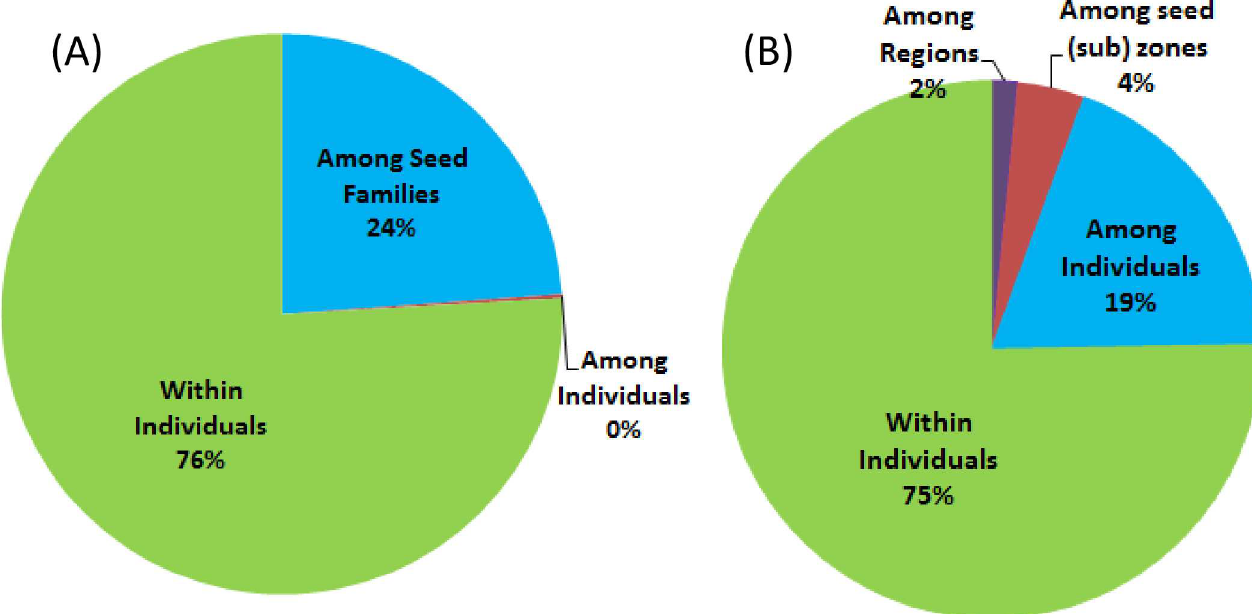
Fig 5. Analysis of Molecular Variance (AMOVA) of whitebark pine samples collected in western North Americafor a breeding program. (A) AMOVA basedon seed families. (B) AMOVA based on seed (sub) zones.